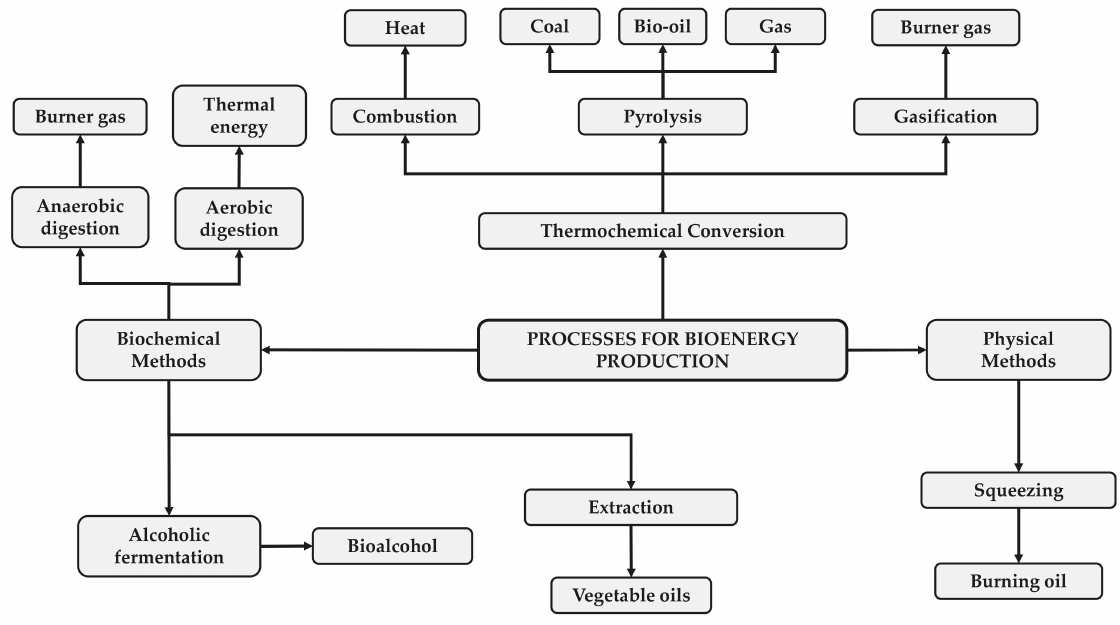
Figure 2. Processes for bioenergy